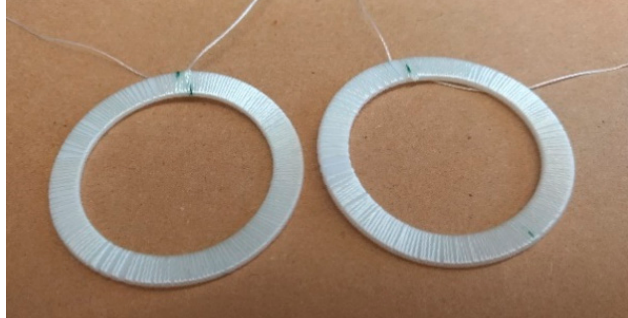
Figure 1. Nylon threads coiled around Teflon rings.